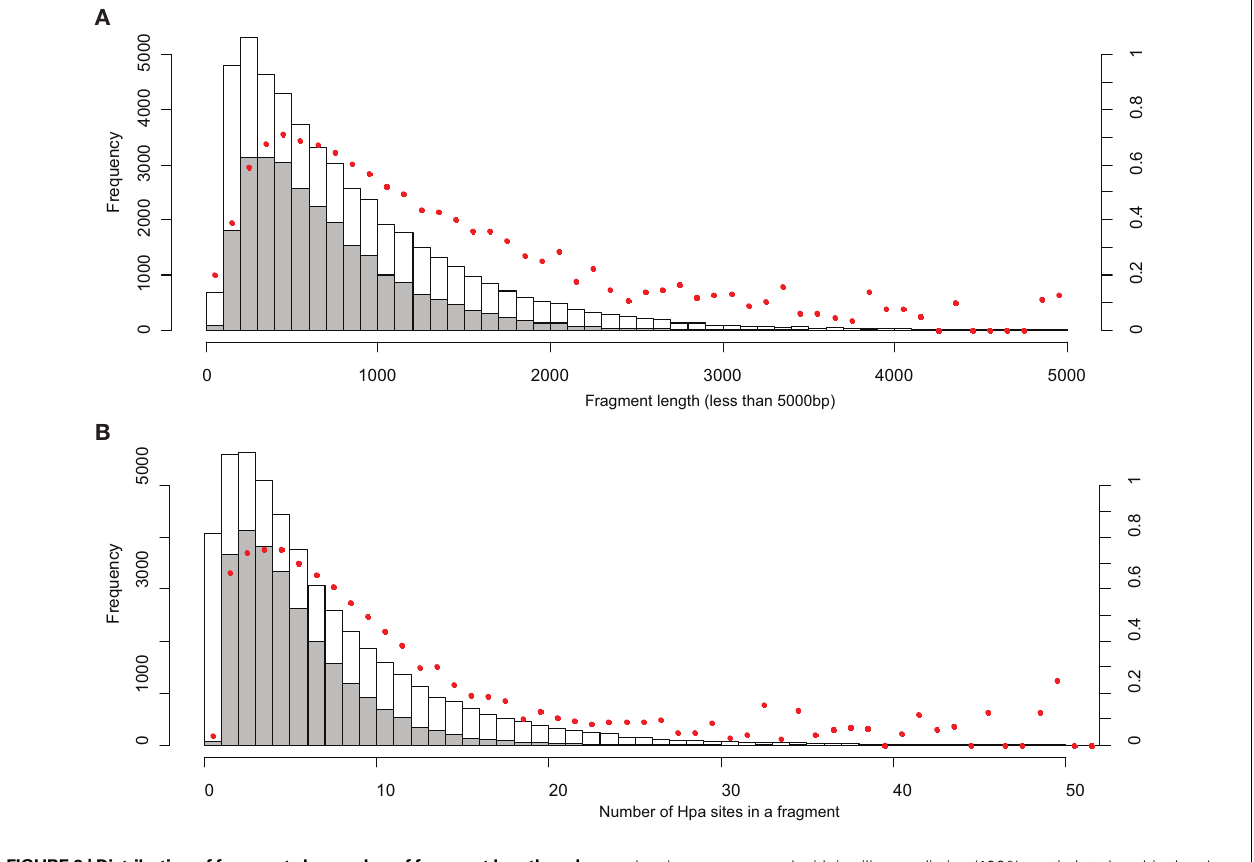
FIGURE 3 | Distribution of fragments by number of fragment length and HpaII sites correlated with positive control results. The histograms were generated from the in silico determined (A) number of fragment length sites and (B) internal HpaII sites. Positive fragments for SssI treated human brain DNA were identifi ed using a p ≤ 0.005 threshold. Experimental results (gray